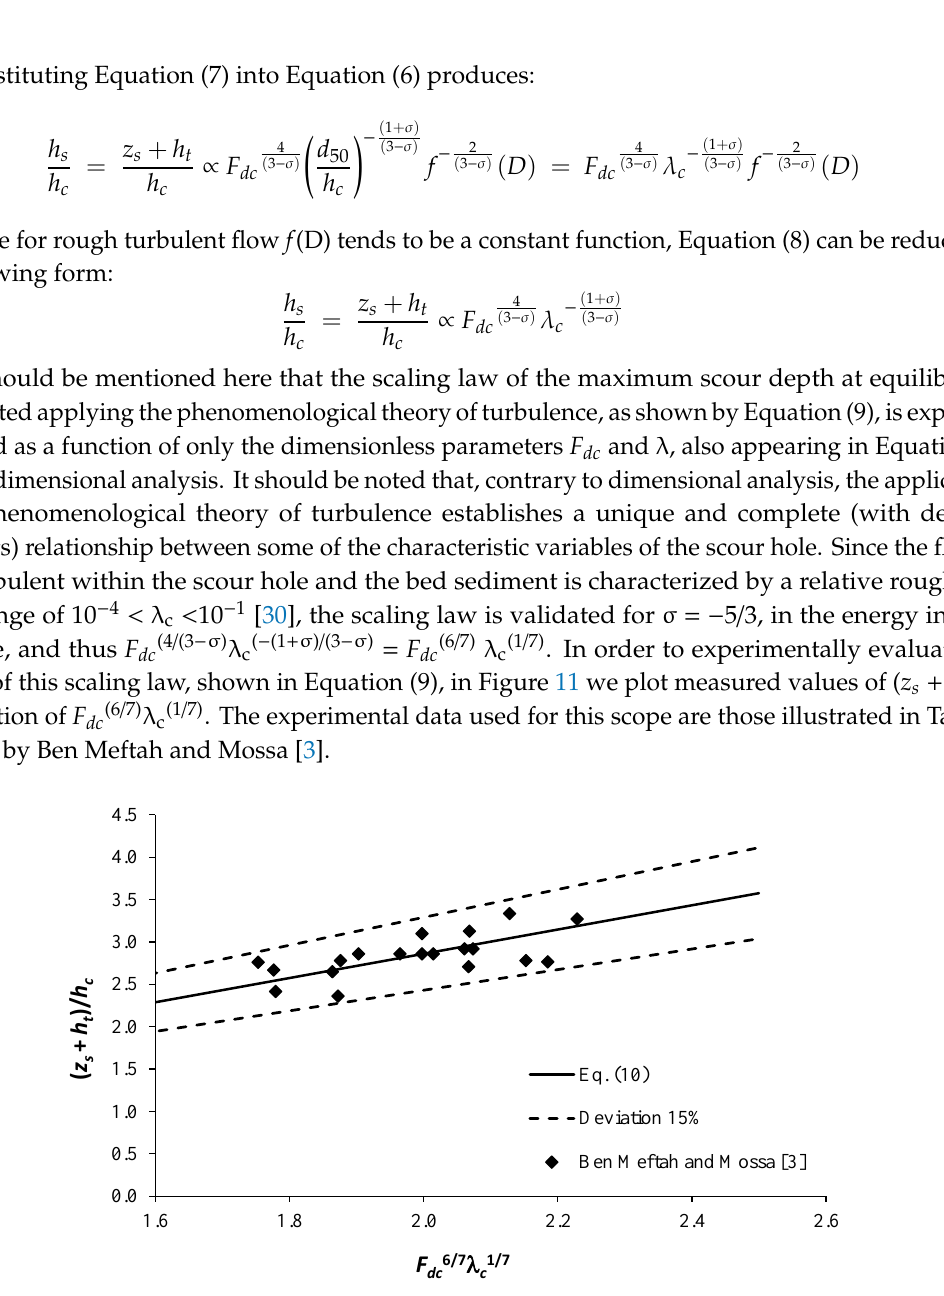
Figure 11. Validation of the scaling law of the maximum scour depth downstream of bed sills obtained by applying the fundamental laws of turbulent energy spectrum with σ = − 5 / 3, and thus F dc (4 / (3 − σ ) λ c( − (1 + σ ) / (3 − σ ) = F dc (6 / 7) λ c(1 / 7) . The data of Ben Meftah and Mossa [3] were obtained downstream of bed sills in alluvial channels and with a bed sediment size of d 50 = 1.8 mm.